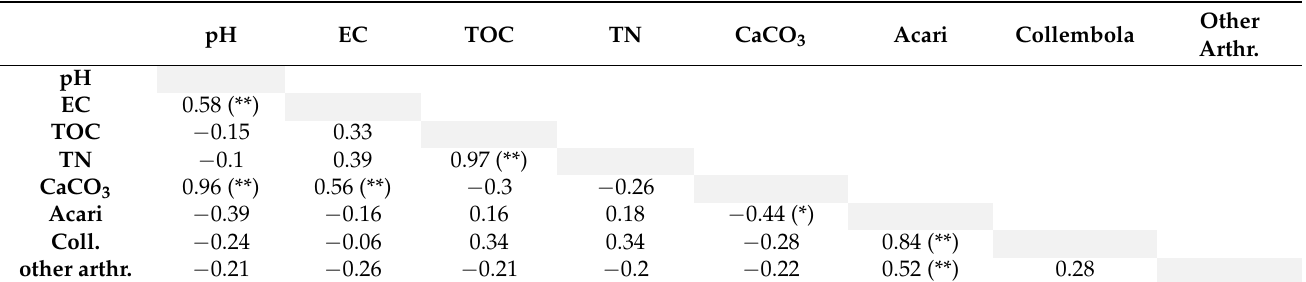
Table 4. Pearson’s correlation coefficients (significance level, two-tailed test: p < 0.05 *; p < 0.01 **) showing interactions among chemical properties of superficial soil samples and mean abundance of arthropod groups in different vineyards. Other CaCO 3 Acari Collembola